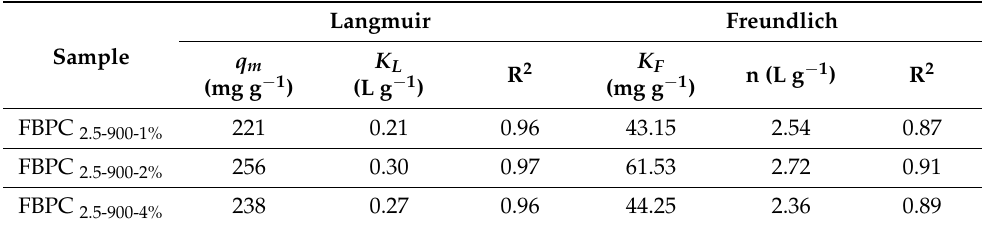
Table 3. Kinetic adsorption parameters for the process of Cu(II) removal by the FBPC samples.